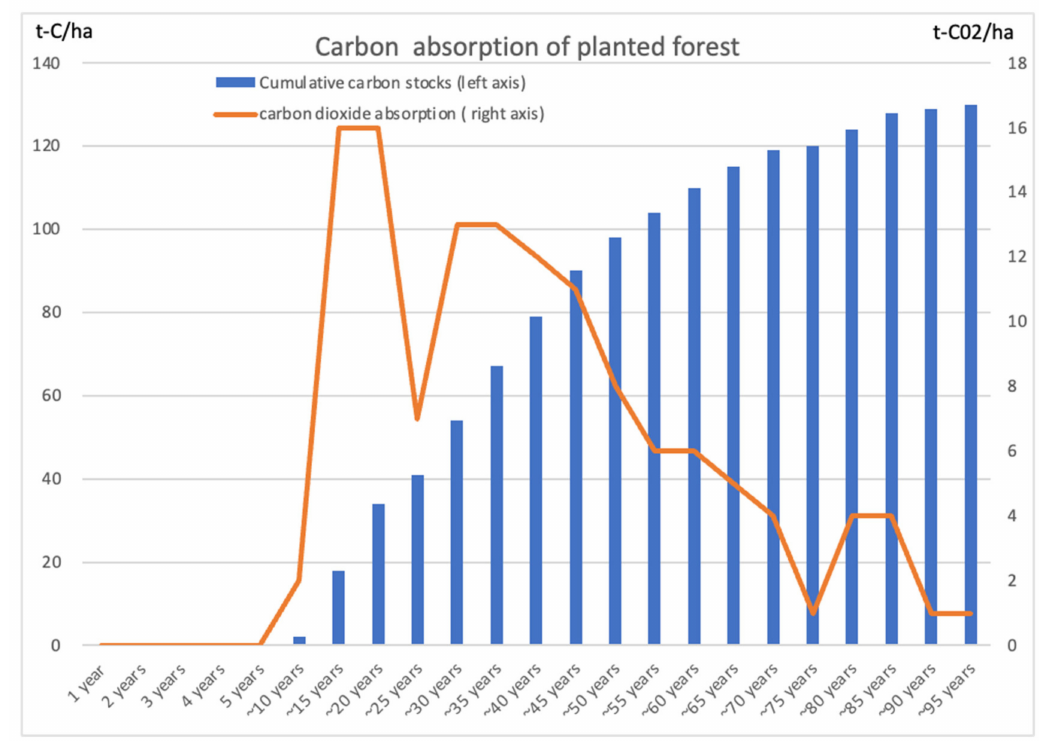
Figure 1. Cumulative carbon absorption and carbon-absorption period in a general Japanese cedar production forest. Source: